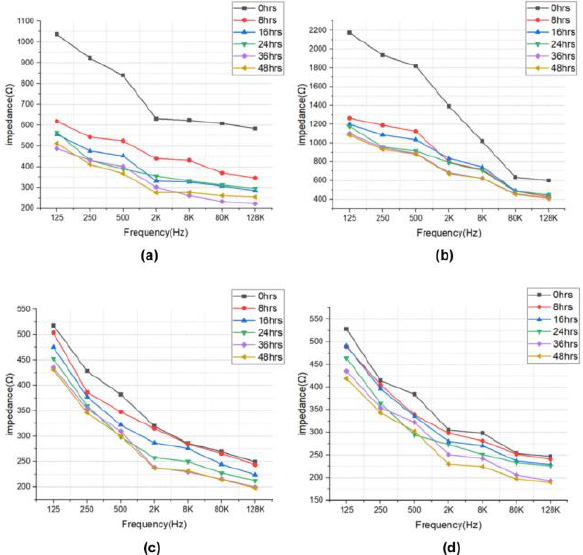
Figure 8. ( a ) Beef tenderloin (quality class 1+), ( b ) beef tenderloin (quality class 1), ( c ) beef round (quality class 1+) and ( d ) beef round (quality class 1) EIS (reprinted from Ref. [20]). Sun Jian et al., Niu J et al., Pérez-Esteve E et al. and Liang Liming et al. [22 – 28] real-